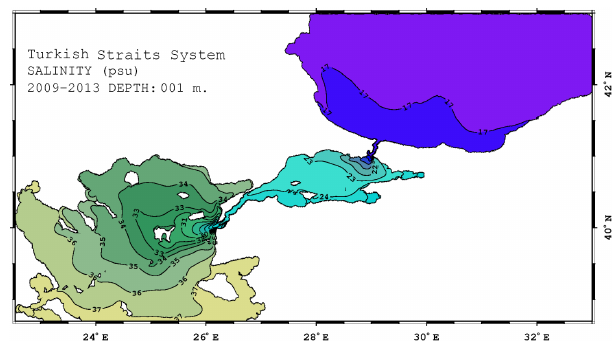
Figure 5. The mean sea surface salinity for 2009–2013. Contours are overlaid with a 1psu